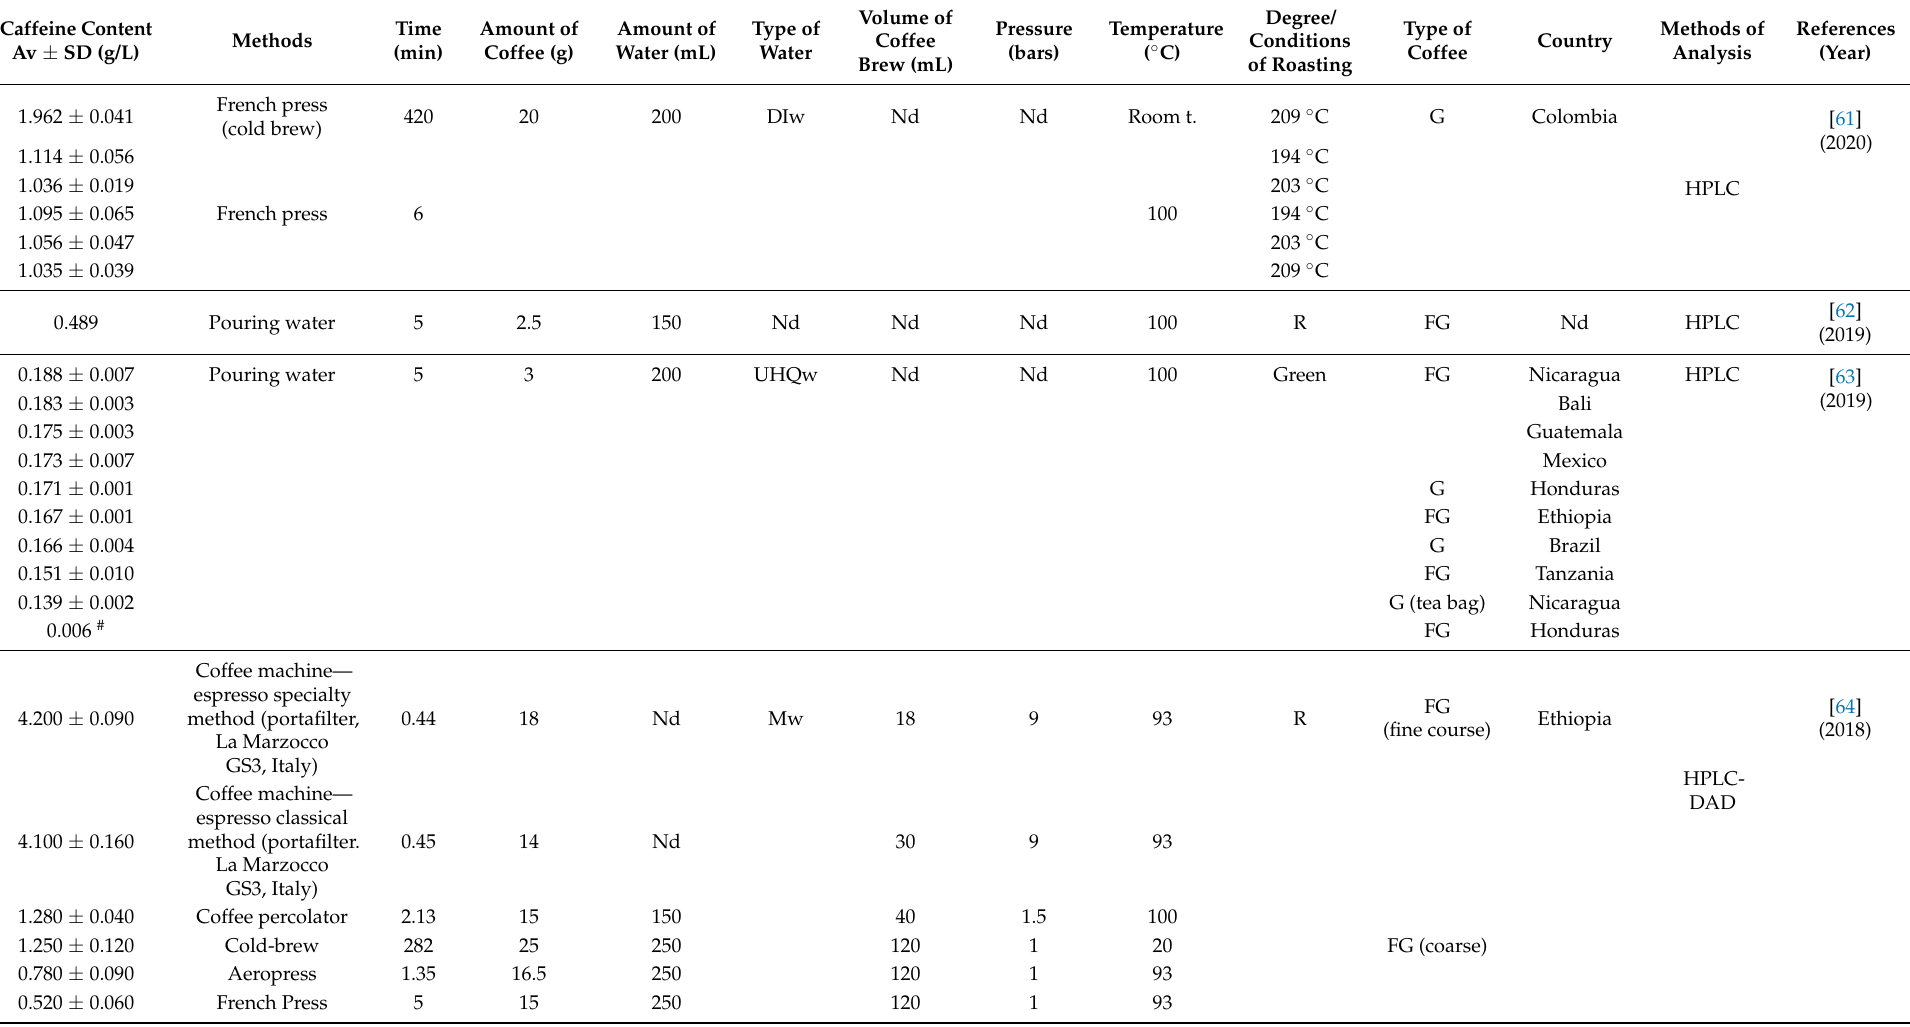
Table 1. Caffeine content (g/L) in 100% Arabica coffee